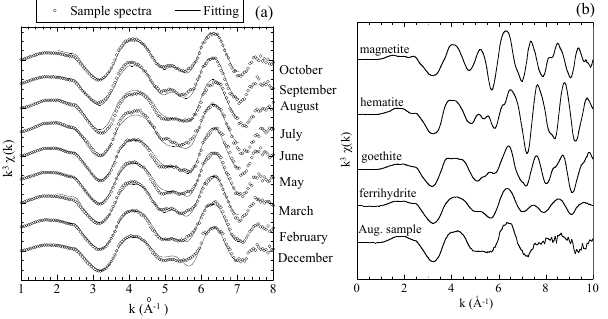
Fig. 7. (a) Fitting of Fe K-edge EXAFS spectra in k space for aerosols collected at various months with (b) the reference spectra for various Fe oxide